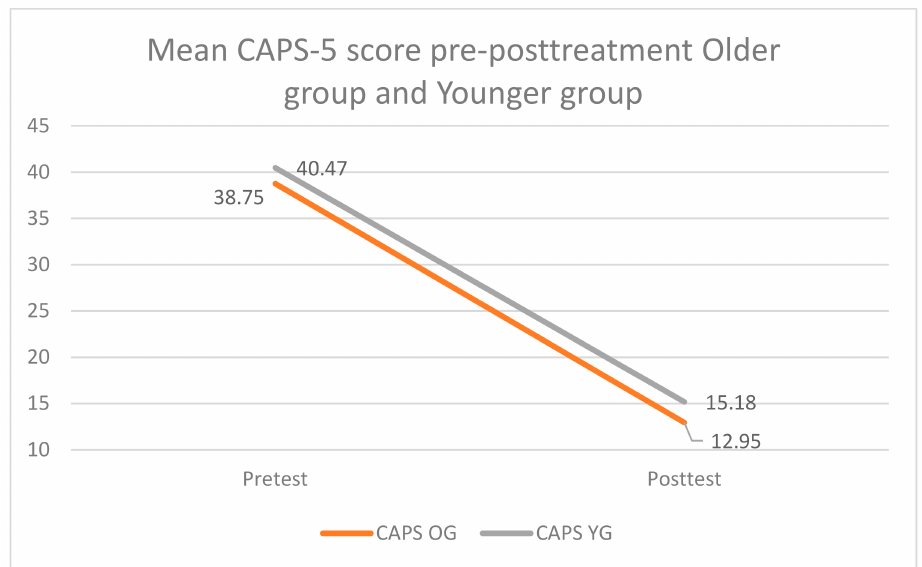
Figure 2. Pre and post-treatment mean scores for the older group and the younger group. Notes: CAPS = Clinician-Administered PTSD Scale; OG = older group; YG = younger